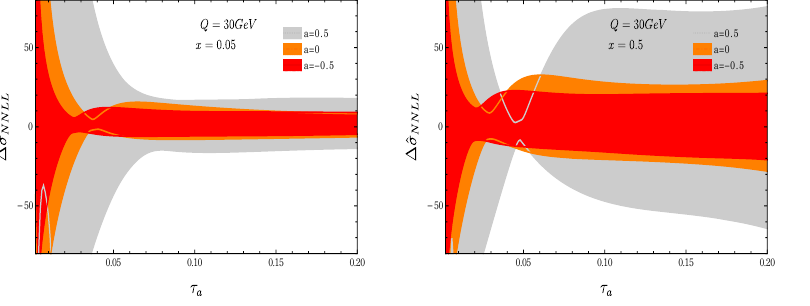
Figure 6 . Relative uncertainties at NNLL for different angularity a dependence on different x = 0 . 05 , 0 . 5 and a = − 0 . 5 , 0 , 0 . 5